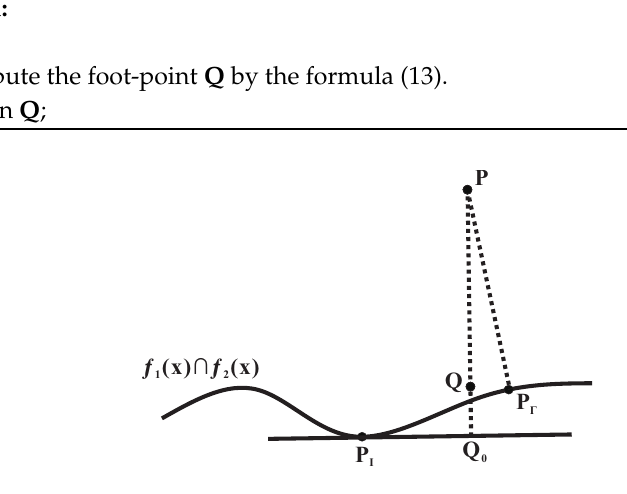
Figure 3. Graphic demonstration for Algorithm